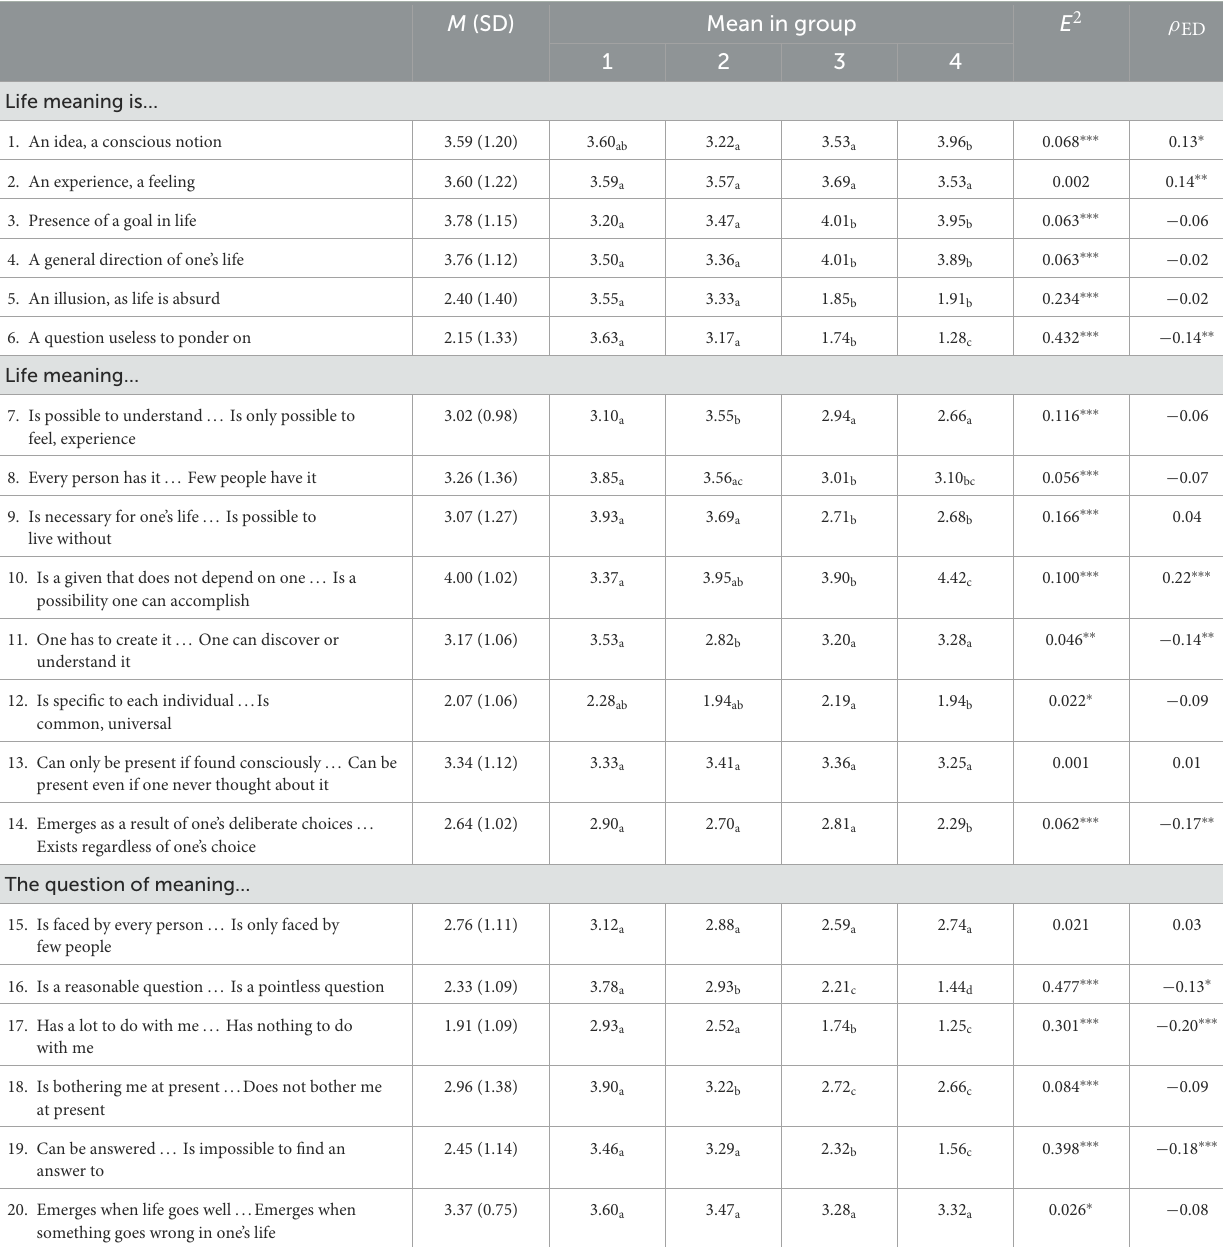
TABLE 3 Descriptive statistics and Spearman correlations with ED ( N = 362) for the ITLM items. M (SD) Mean in group E 2 ρ